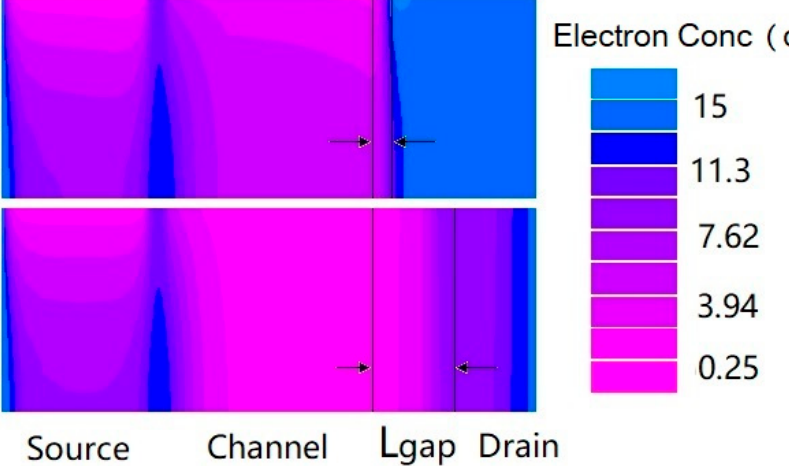
Figure 4. Electron concentration contour of proposed in-built N + pocket ED-TFET with an ED drain for L gap of 5 nm ( up ) and 20 nm ( down ) at OFF state.